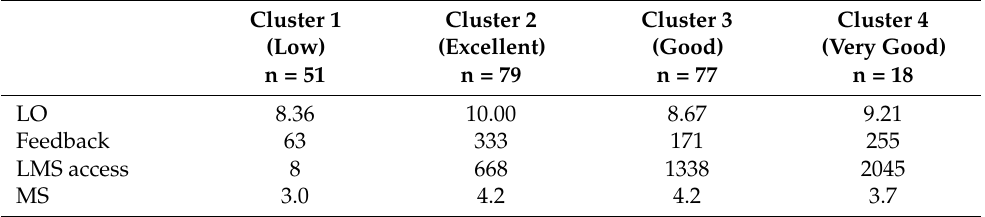
Table 4. Centres of final clusters for the variables LO, feedback, LMS access, and MS .